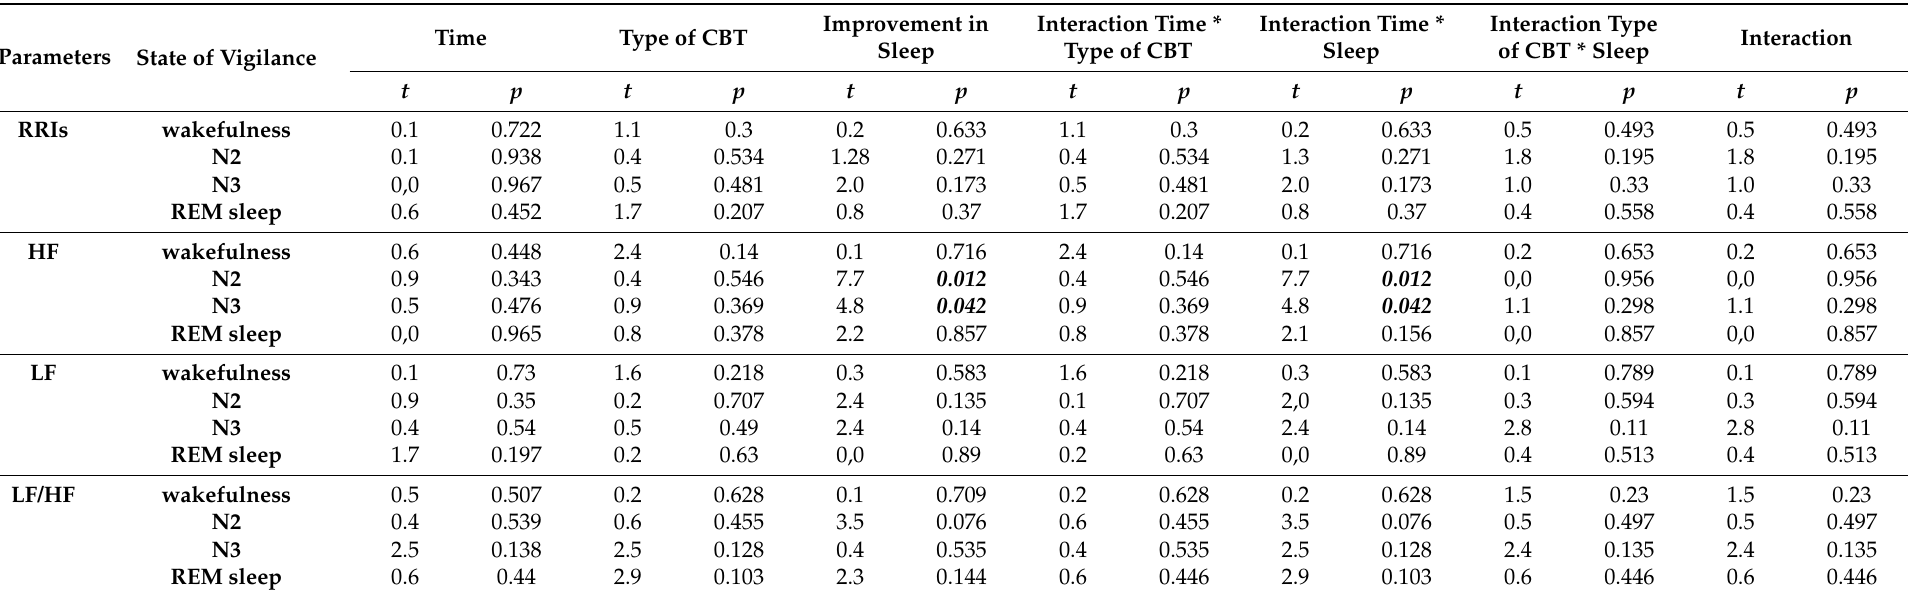
Table 4. Changes in HRV parameters in the treatment groups according to responders vs. non-responders to perceived sleep